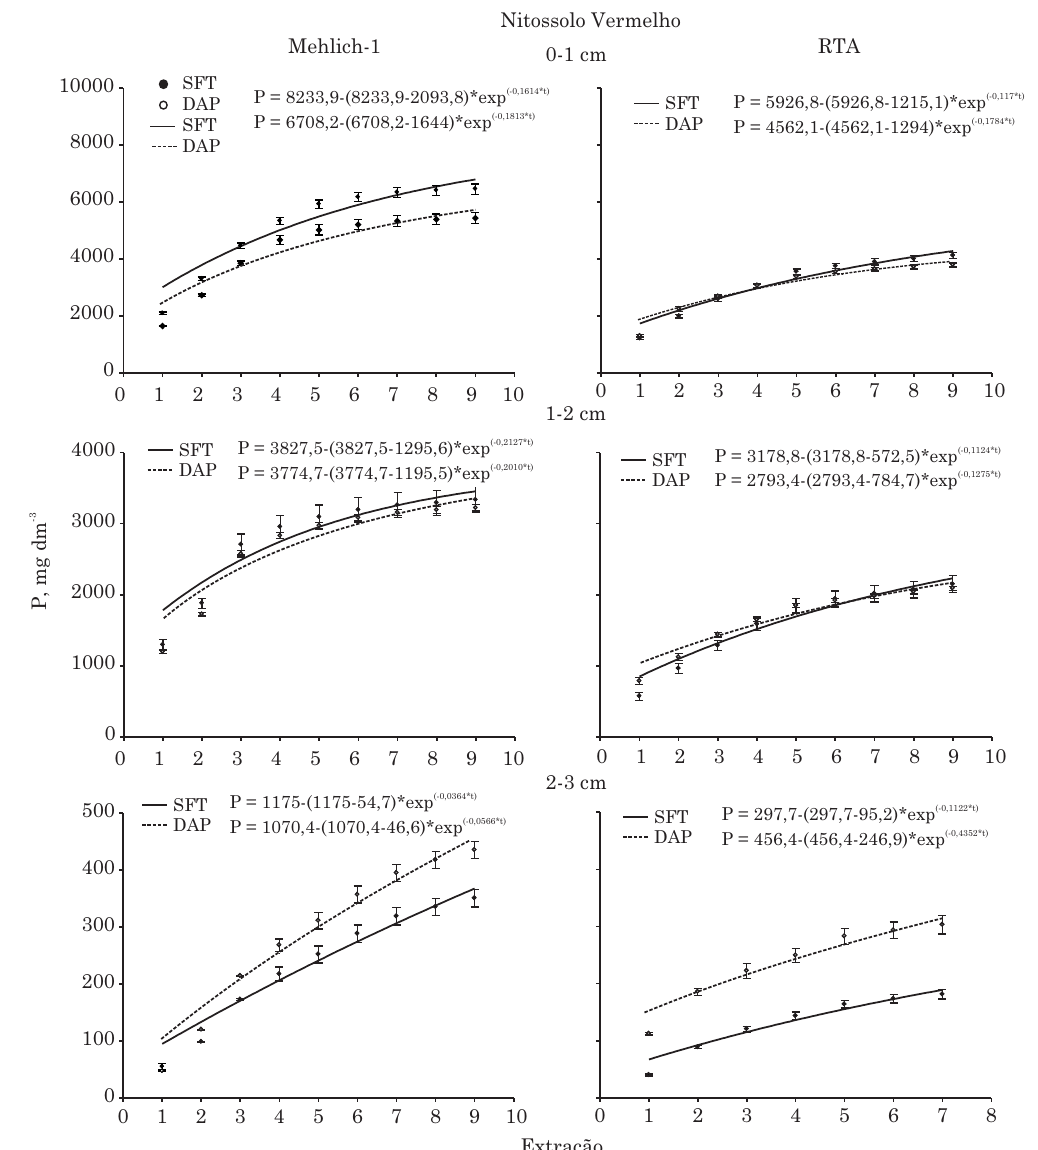
Figura 1. Dessorção acumulada de fósforo ao longo de nove extrações sucessivas em diversas camadas distante do local de aplicação dos fertilizantes em um Nitossolo Vermelho, quantificada pelos métodos Mehlich-1 e da resina trocadora de ânion (RTA). SFT: superfosfato triplo; e DAP: diamônio